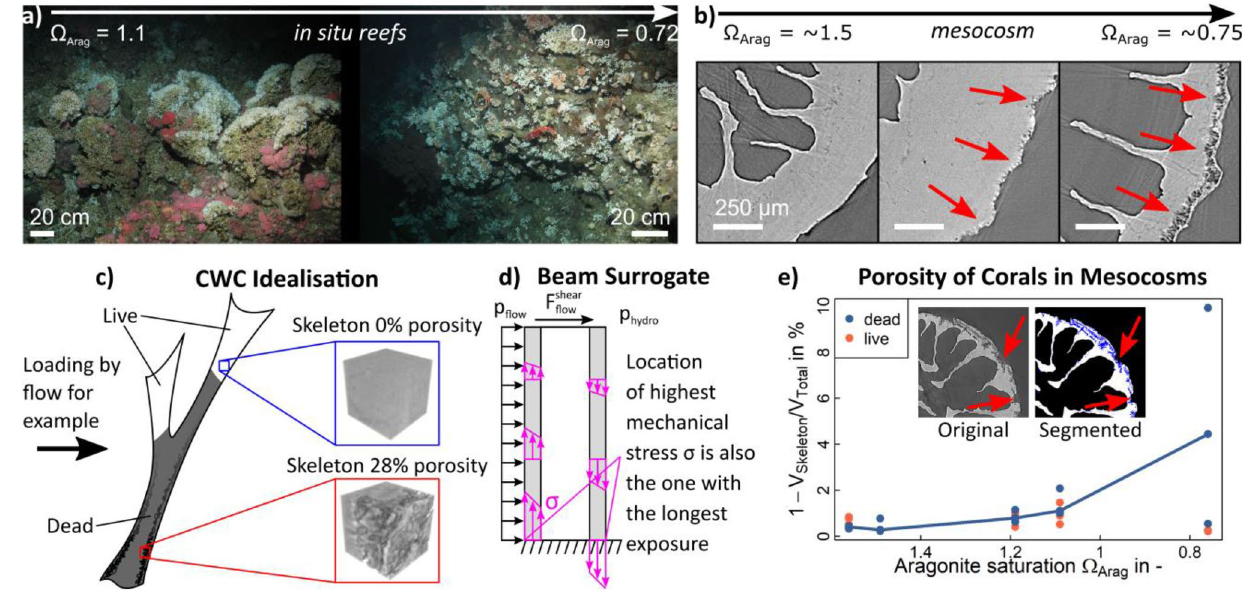
Figure 1. Cold-water corals (CWCs) in an acidifying ocean: ( a ) The transition of a high complexity reef with live coral (white tips) and dead coral (grey thicket) skeleton at � Arag > 1 , to one with low complexity and no dead skeleton at � Arag < 1 , is governed by collapse of the foundation framework due to rapidly increasing porosity in dead coral skeleton and subsequent dissolution when subjected to corrosive conditions (decreasing (cid:31) Arag ). ( b ) CWC skeletons exposed to future oceanic conditions for 12 months in vitro showed significantly increased porosity 9 (red arrows) for low (cid:31) Arag . This was measured as skeleton pore volume (blue inlays in ( e )) over total skeletal volume (white + blue inlays in ( e )), which is a conservative approach. For a pre-defined volume of interest, e.g. the red one in ( c ) with 120 µm edge length, porosity was 28%. If the coral is simplified as a hollow beam loaded by, e.g. loads due to water flow (cid:31) p flow , F shear flow (cid:30) and hydrostatic pressure clear that porosity and dissolution affect the reef at its weakest point ( c , d ). ( e ) Porosity increased significantly with decreasing (cid:31) Arag in dead but not in live skeletons 9 . (Images and data from 9,10